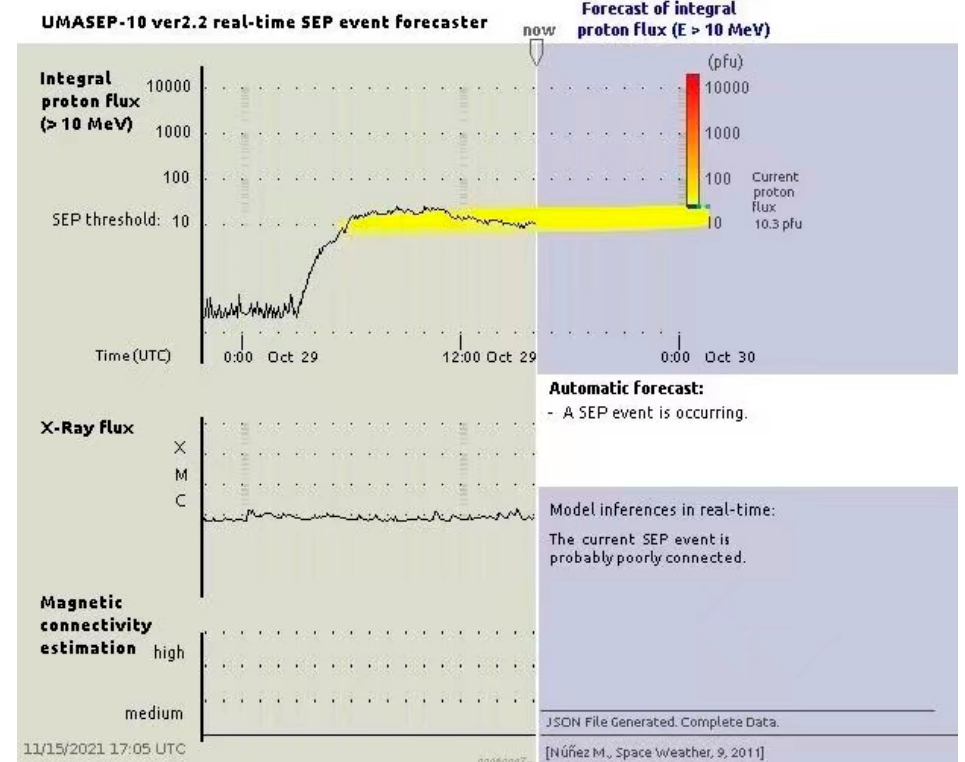
Figure 6. Graphical output of the UMASEP-10 version 2 tool for the SEP event on 29 October 2015, which was associated with a behind-the-limb flare at ~S11W135 [35,41]. This event was predicted by the PCP model (see Section 2.2); it was not predicted by